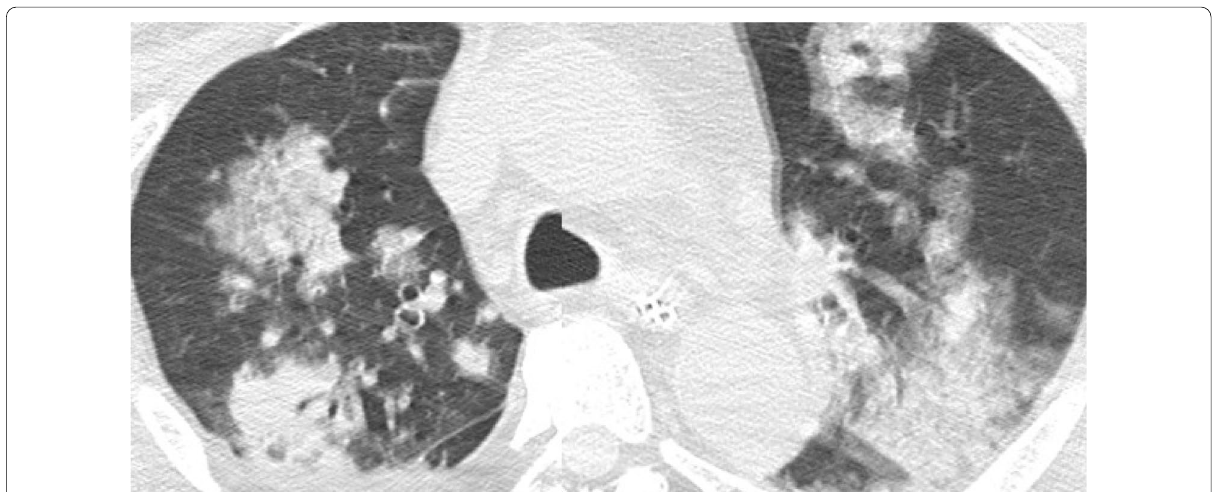
Fig. 2 Computed tomography scan performed on postoperative day 1. Nodular shadows with the halo sign were